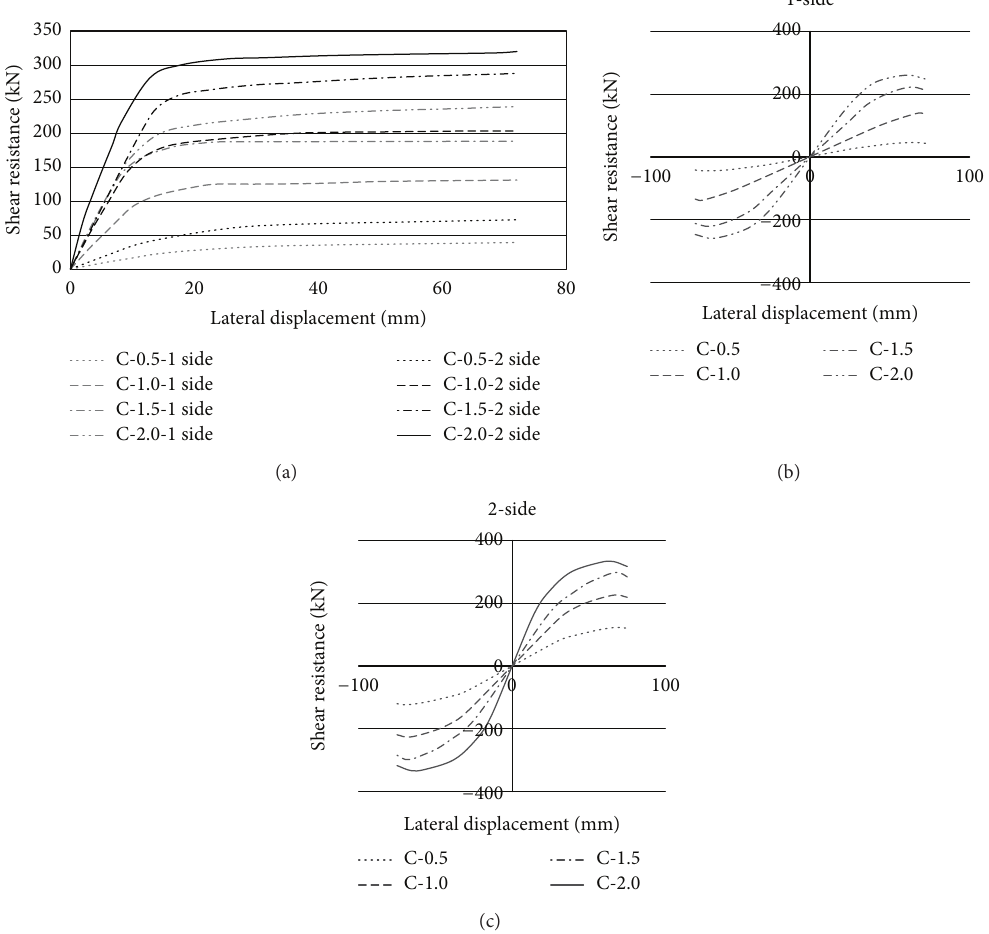
Figure 5: Curves of specimens C. (a) Monotonic curves. (b) Hysteretic envelope curves 1-side. (c) Hysteretic envelope curves 2-side.